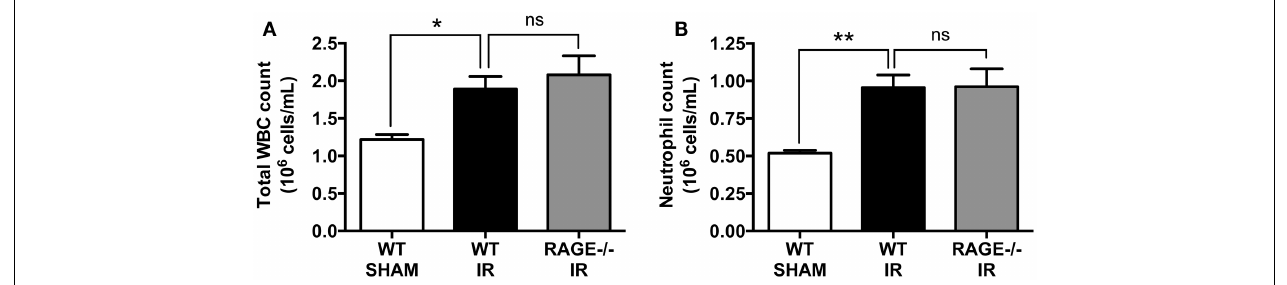
FIGURE 3 | Elimination of RAGE does not affect total white blood cell and blood neutrophil counts following intestinal IR . Mice were subjected to 30min mesenteric artery occlusion, followed by 150min reperfusion. The numbers of (A) white blood cells (WBC) and (B) neutrophils, in the peripheral blood collected after